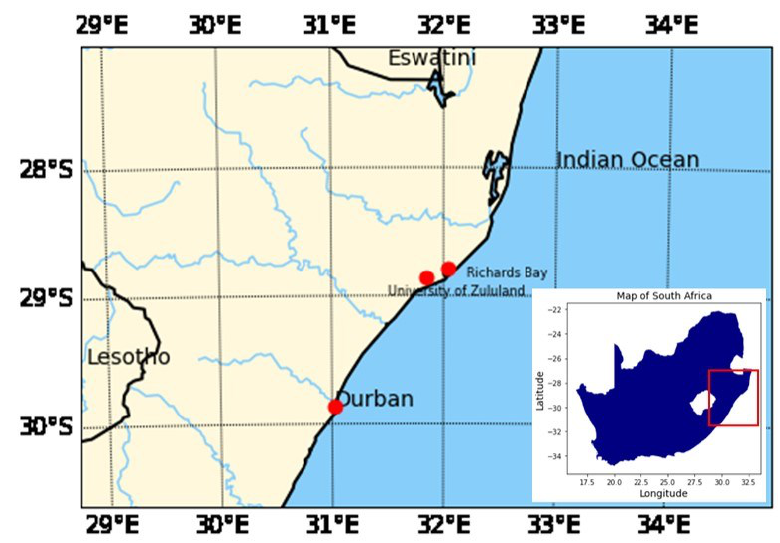
Figure 1. Map of South Africa with the location of the study area. The University of Zululand is located in the south-west of Richards Bay.